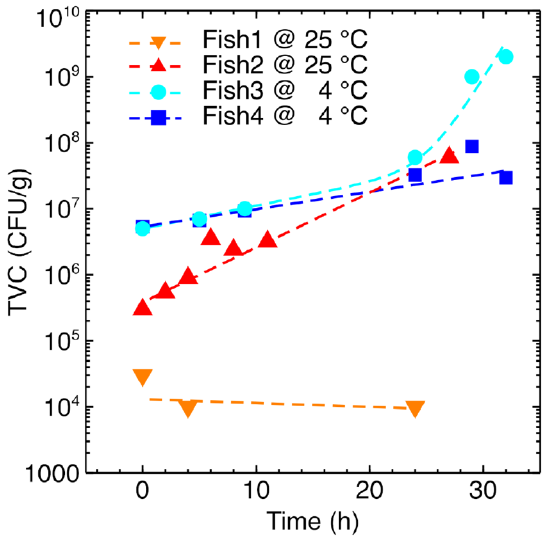
Figure 5. Microbiological characterization of fish samples: time dependence of the total viable count (TVC). Dashed lines are guides for the eye.